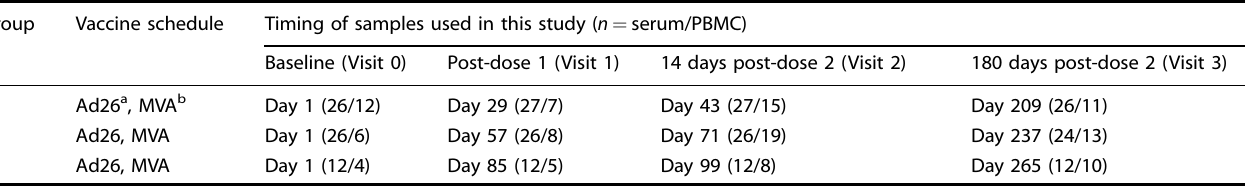
Table 1. Randomised vaccination regimen and corresponding numbers of serum and PBMC samples used in this study. Group Vaccine schedule